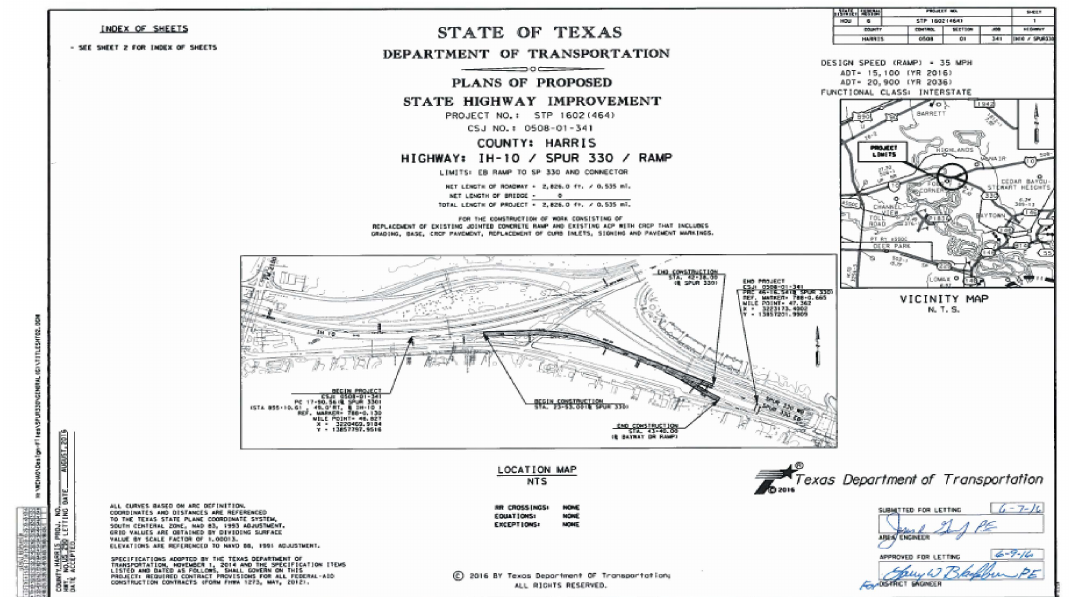
Figure 3. Reconstruction project of I-10 east ramp exit to Spur